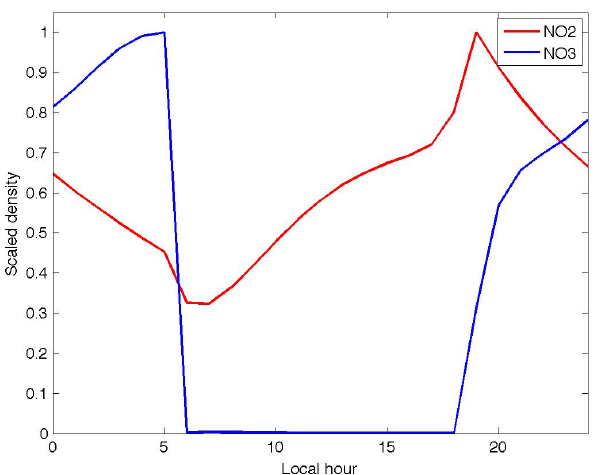
Fig. 17. NO 2 number density vs. local time at 30km and NO 3 number density vs local time at 40km. The number densities are scaled by the maximum values reached at a given altitude. Results are from the NCAR ROSE model in 5 ◦ S–5 ◦ N.